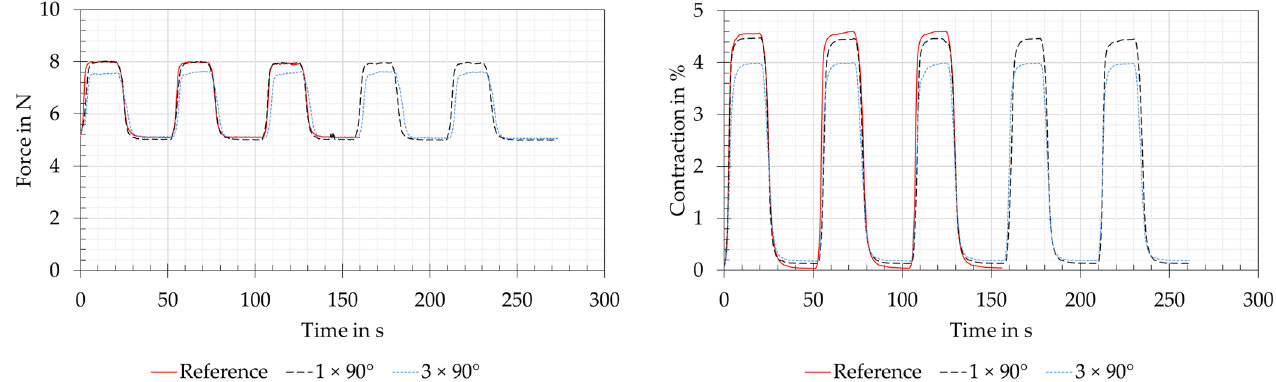
Figure 11. Straight and deflection versions: force and contraction measurements for the reference measurement on the straight clamped SMA wire actuator, with the deflection by 1 × 90° and 3 × 90°. The wire length was 250 mm for all deflection versions, and measurements are taken with 5 N.